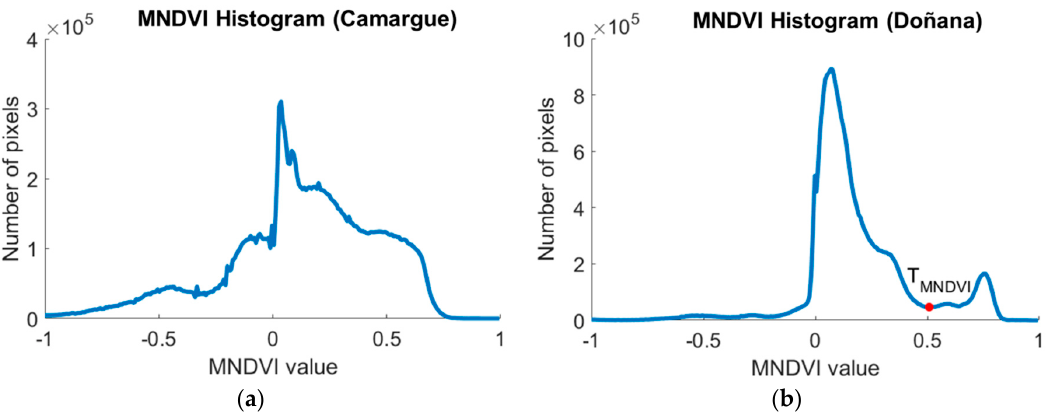
Figure 5. Histogram of the MNDVI map for ( a ) Camargue on 18 August, 2017, and ( b ) Doñana on 20 August, 2017. T MNDVI is the MNDVI value for which the first deep valley after 0.4 is detected in the MNDVI histogram (red point). T MNDVI is detected only on the right